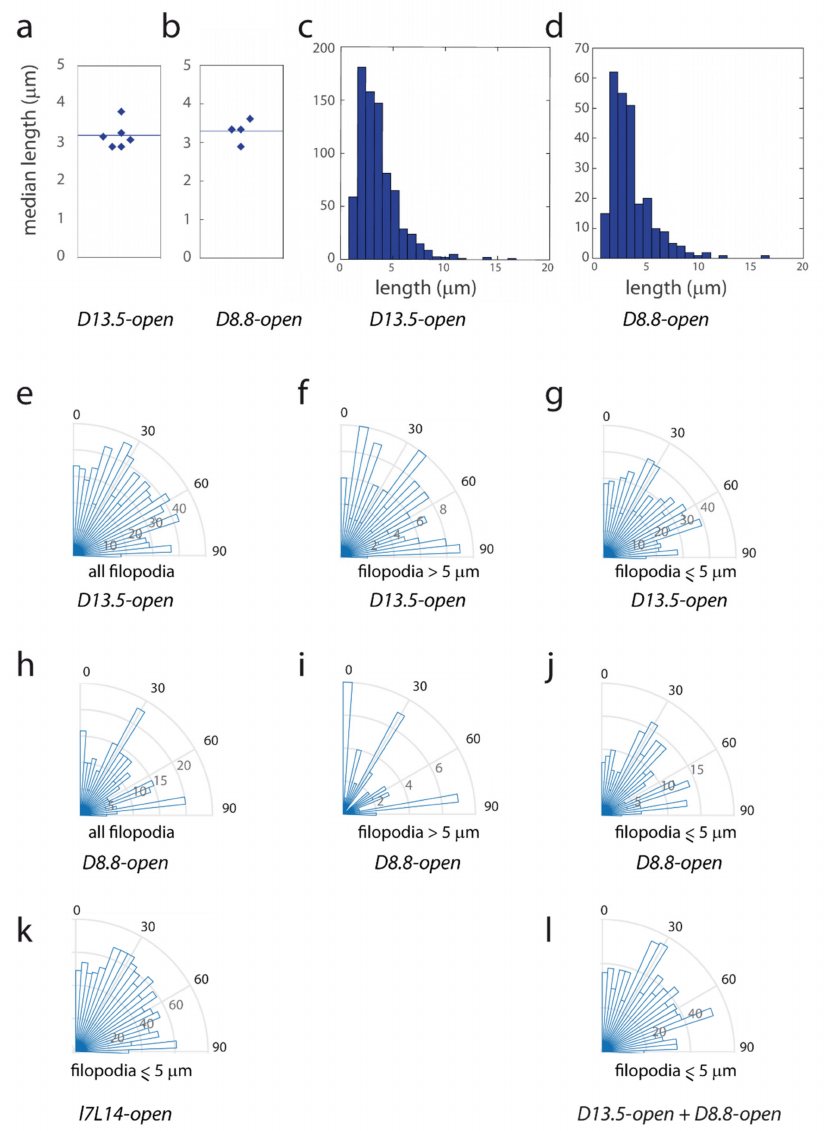
Figure A6. Filopodia orientation on regular lattices of different dimensions. ( a , b ) Median filopodia lengths, one point corresponds to one structure (bar: mean value), for D13.5-open ( a ) and D8.8-open ( b ) structures. ( c , d ) Histogram of filopodia lengths, for D13.5-open ( c ) and D8.8-open ( d ) structures (respectively 782 and 256 filopodia). ( e – l ) Histograms of filopodia orientation. The angle with the reference axis of elongated structures was computed. ( e – g ) D13.5-open structures, ( e ) all filopodia, ( f ) filopodia with length > 5 µ m, ( g ) filopodia with lengths ≤ 5 µ m. ( h – j ) D8.8-open structures, ( e ) all filopodia, ( f ) filopodia with length > 5 µ m, ( g ) filopodia with lengths ≤ 5 µ m. ( k ) l7L14-open structures, filopodia with lengths ≤ 5 µ m. ( l ) D13.5-open + D8.8-open structures, filopodia with lengths ≤ 5 µ